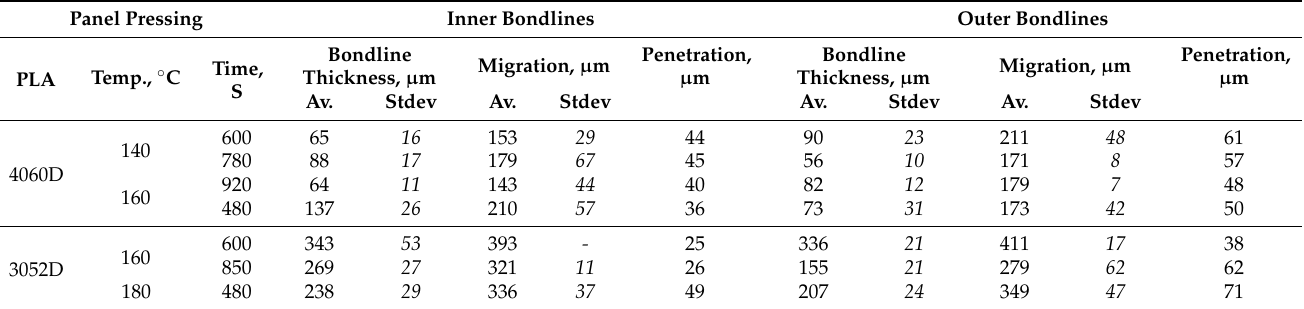
Table 2. Summary of PLA bondline thickness and polymer migration and penetration results in panels formed with radiata pine veneer and semi-crystalline and amorphous PLA grades at differing pressing temperatures and